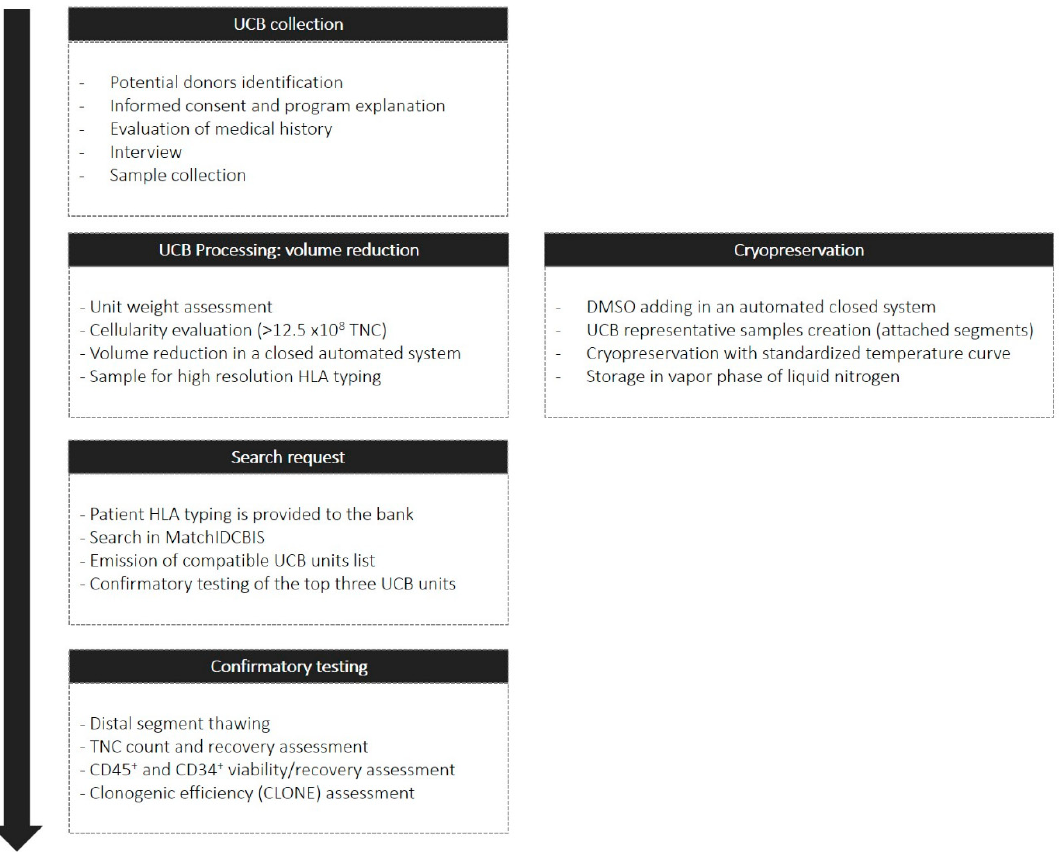
Figure A1. Flow work of UCB collection, volume reduction, cryopreservation, search request, and confirmatory testing in the umbilical cord blood